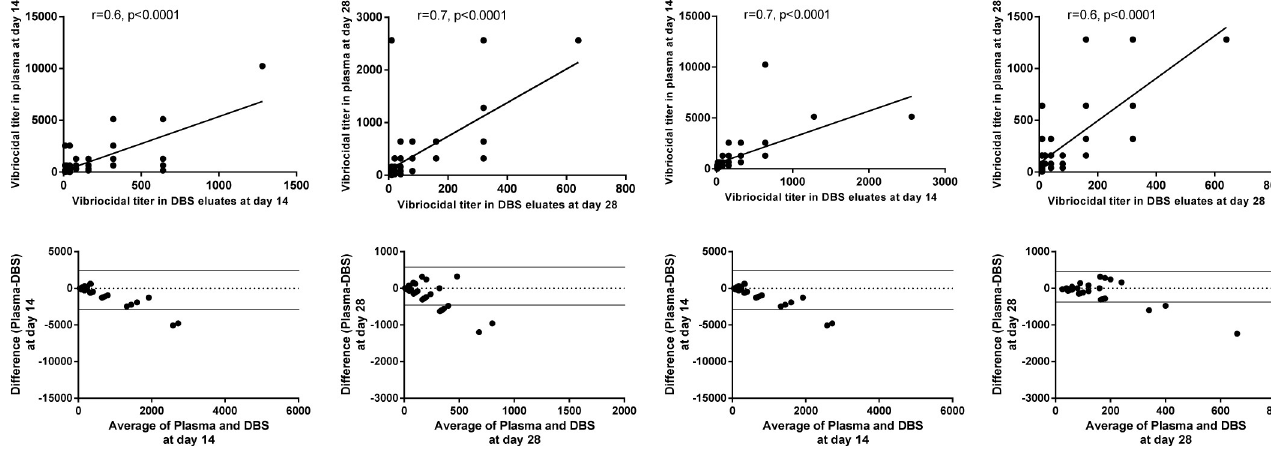
Fig 6. Correlations and the Bland-Altman analysis of vibriocidal antibodies in plasma and DBS eluates to Inaba serotype in adults and older children. Spearman correlation of vibriocidal responses in plasma and DBS eluates at day 14 and 28. Bland-Altman analysis of vibriocidal responses in plasma and DBS eluates of OCV recipients of FDMN at day 14 and